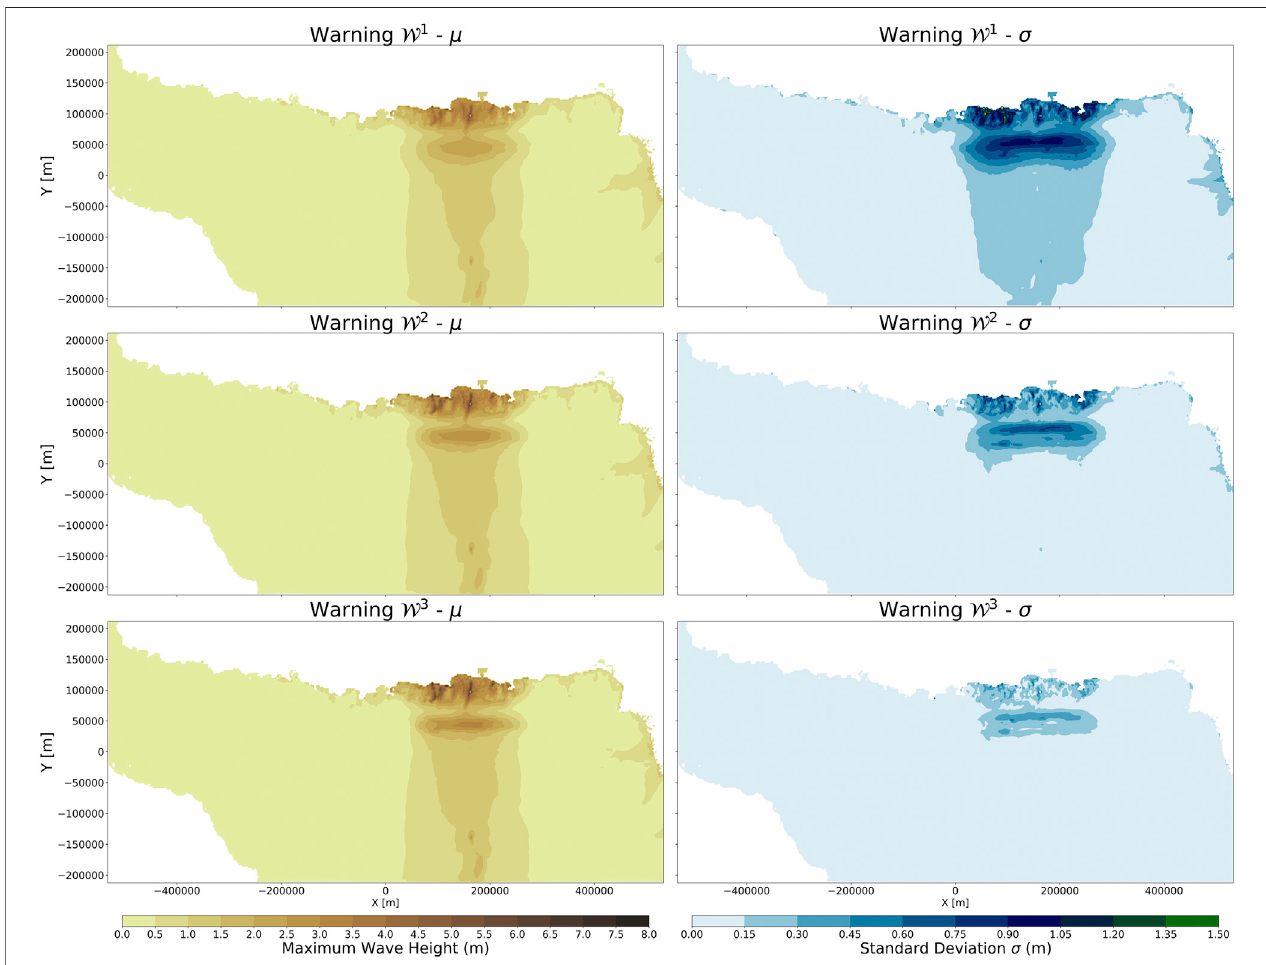
FIGURE 11 | Regional map of uncertainties generated from emulator predictions of η max at 50,983 locations picked from a rectangular grid, for fi rst (top) , second (middle) andthird (bottom) stagesofwarning.Eachwarningstagedepictsthemeanofthepredicted η max (left) andassociatedstandarddeviation (right) using n P (cid:2) 1 k samples for prediction ( Figure 6 , Bottom